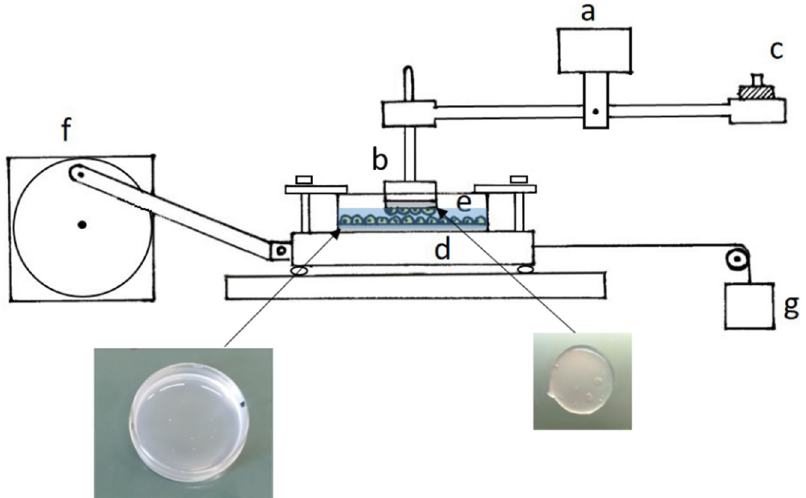
Figure 6. Schematic drawing of the device used to measure frictional forces: ( a ) force transducer; ( b ) Plexiglas rod on which a gel disk with a mesothelial monolayer was glued; ( c ) counterweight; ( d ) sliding platform; ( e ) Petri dish containing cells seeded on gel; ( f ) electric motor; ( g ) differential transformer.